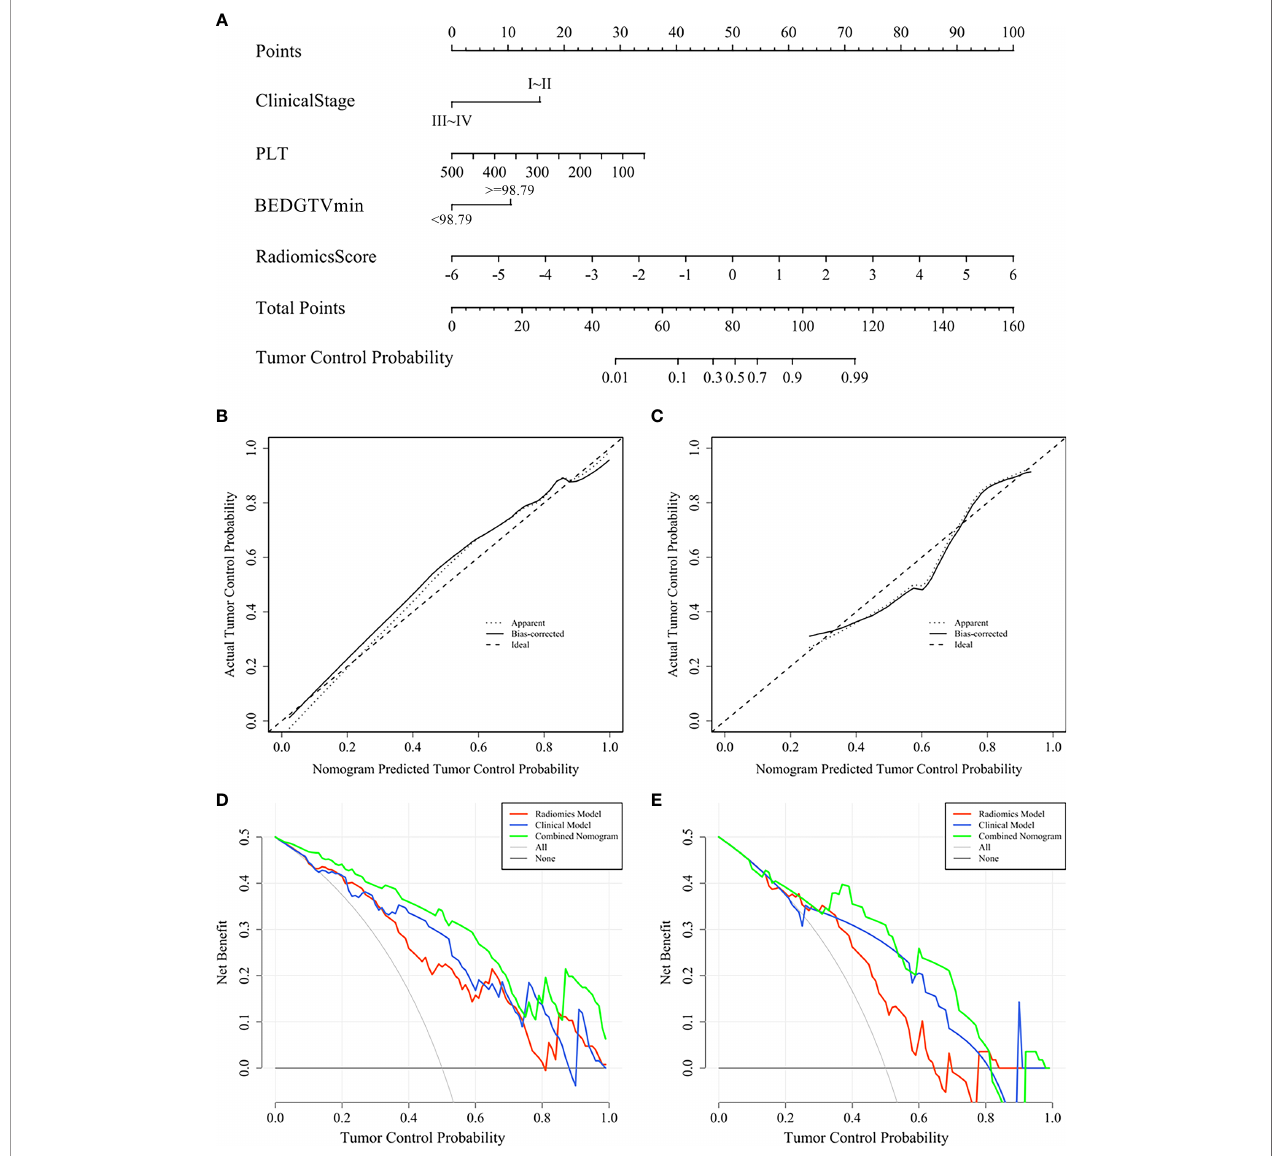
FIGURE 8 | Combined nomogram and evaluation of the nomogram in the training group and validation group. (A) A combined nomogram for prediction 1-year local control probability in lung cancer patients after SBRT. The calibration curve of the combined nomogram in the training group (B) and validation group (C) . The decision curve of each model in the training group (D) and validation group (E)